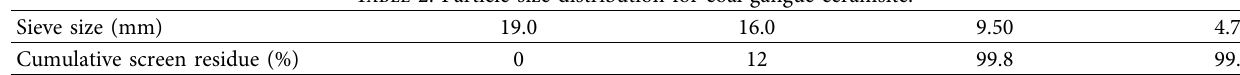
Table 2: Particle size distribution for coal gangue ceramsite.